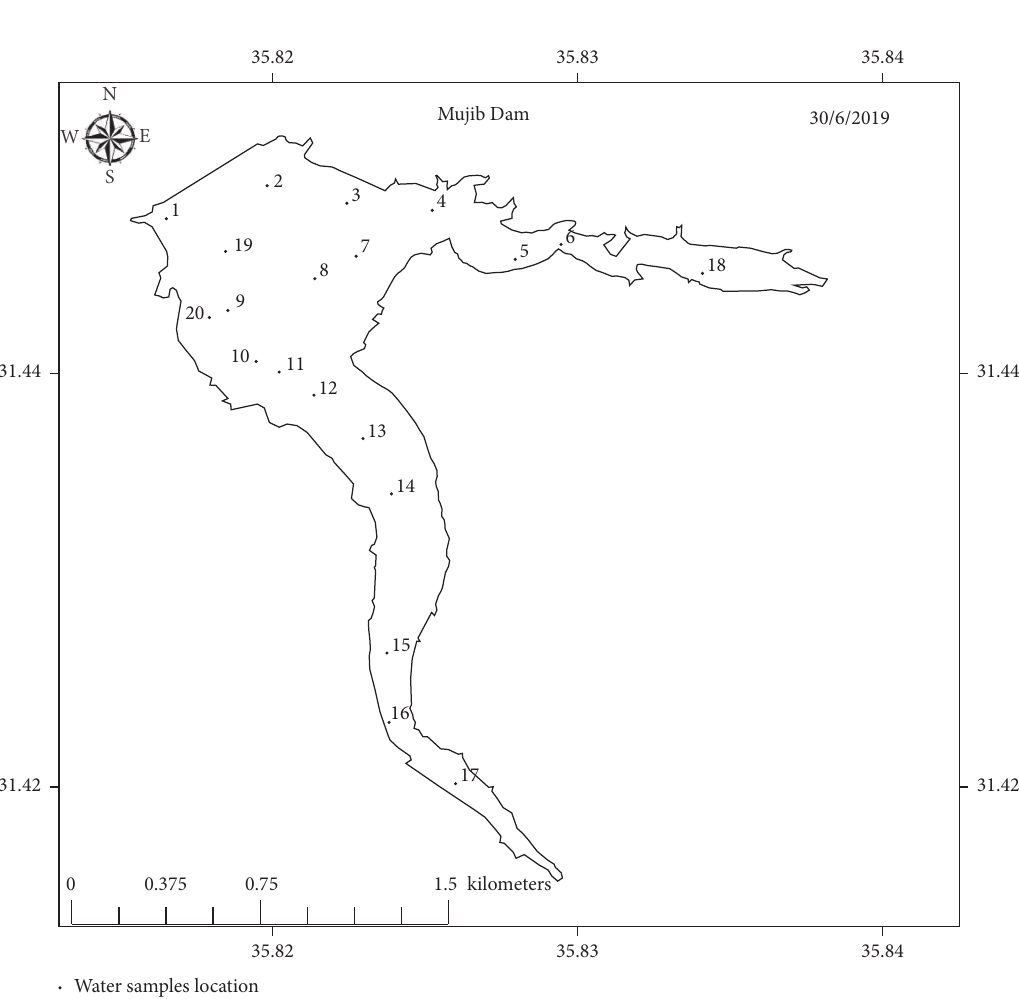
Figure 3: Sampling points distribution of Mujib